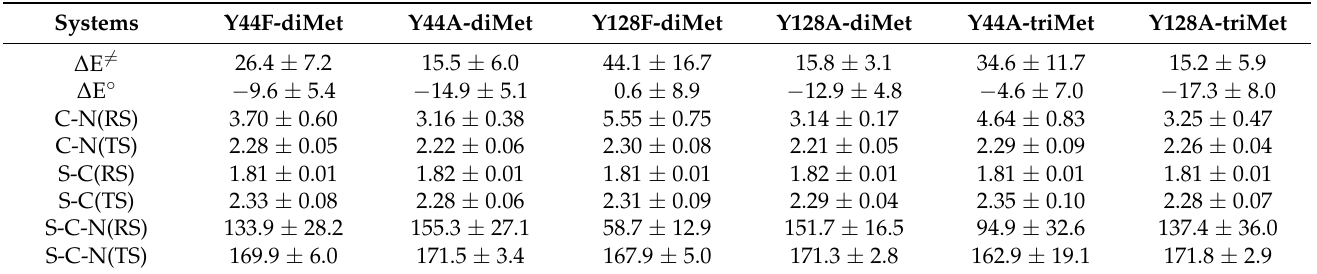
Figure 3. This contributed to the increase in the distances between the interacting parts and the enzymatic machinery and, also, to the inactivation of the substrate. Interestingly, the conformation of Y130 inside the binding site changed completely with respect to the native enzyme, where the latter was located close to the methyl group and the Y128F mutant was located at ~8.0 Å from the methyl group, thereby opening the access of the water molecules located at the vicinity of the binding site. For Y44F (results shown in Figure 4), the inacti- vation mechanism was the same, with a water molecule interacting with the N ε (K4). In both mutants, the methyl group of the MetK4 substrate pointed towards the aromatic ring of residue 44 (Y or F). The main conformational difference between Y44F and Y128F was the hydrogen bond formed between Y128 and the proton from N ε (K4) in the former. The proton in the Y128F mutant did not interact with any residue or water molecule. Table 3. Selected average geometric parameters with their corresponding standard deviations for the RS and TS conformations of the di- and tri-methylation reactions in the mutants Y44F, Y128F, Y44A, and Y128A. Average activation ( ∆ E (cid:54) = ) and reaction energies ( ∆ E ◦ ) are in kcal/mol, distances in Å, and angles in degrees ( ◦ ).